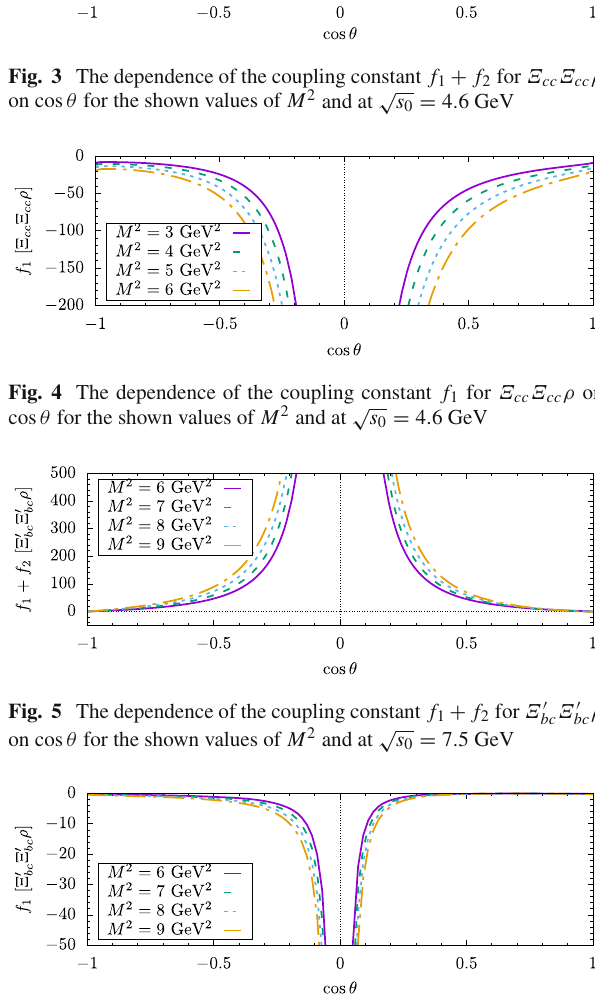
Fig. 6 The dependence of the coupling constant f 1 for Ξ (cid:7) cos θ for the shown values of M 2 and at